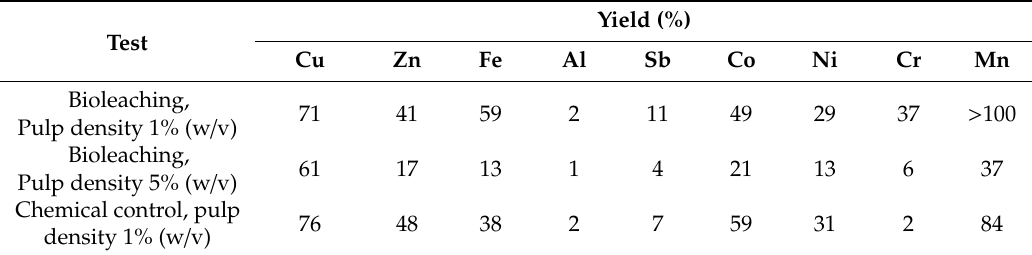
Table 6. Metal yields in the shake flask bioleaching experiments of copper slag after 21 days.